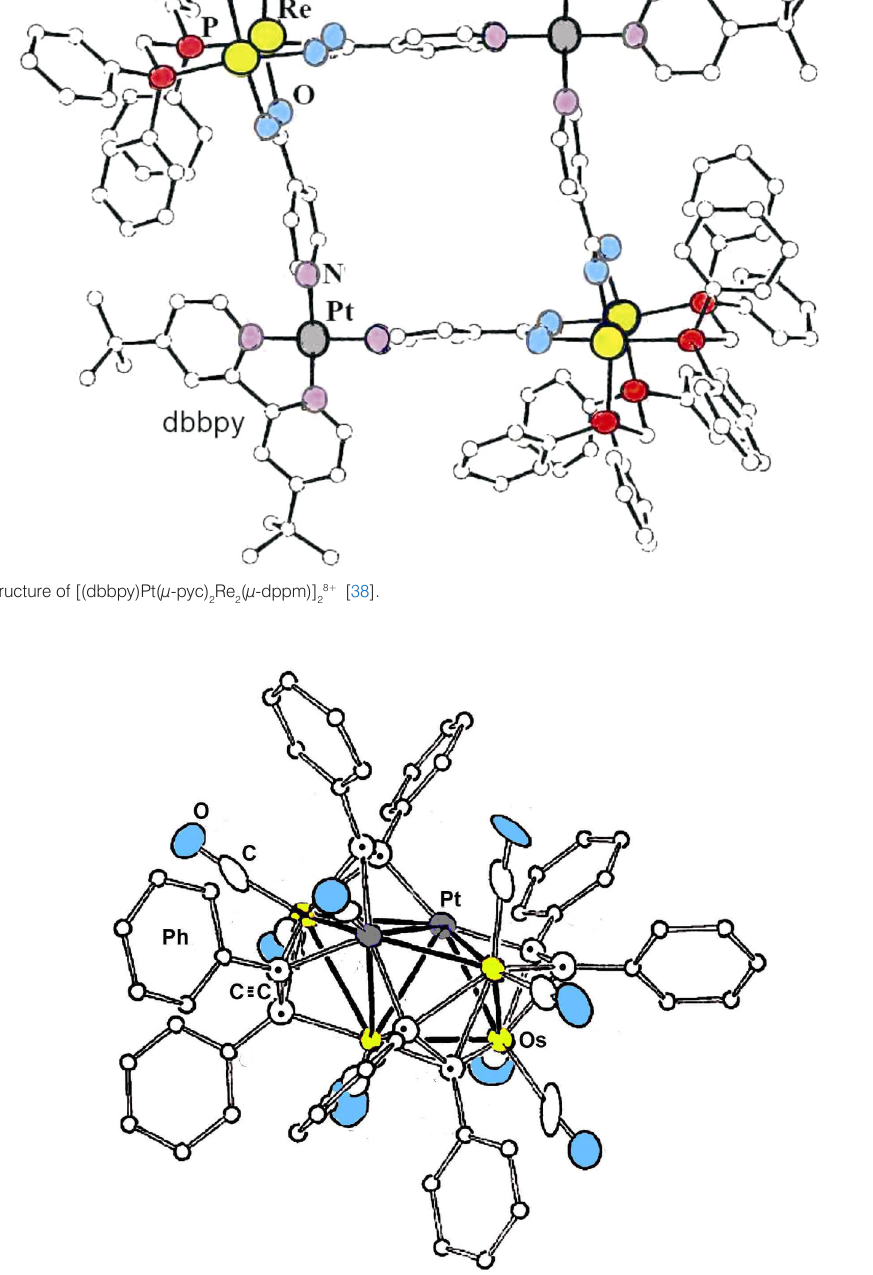
Os (µ -PhC ≡ CPh)(µ 2 4 4